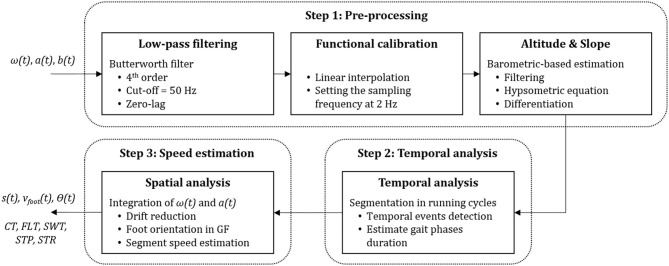
Steps performed on the IMU acceleration a(t), angular velocity ω(t), and barometric pressure b(t) measurements. The outputs were later used for feature extraction; the slope s(t), the speed of the foot vfoot(t), the pitch angle θ(t), contact time CT, flight time FLT, swing phase duration SWT, step duration STP and stride duration STR.